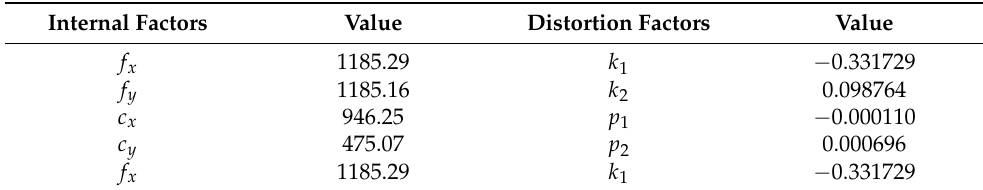
Table 3. SNO-6084R CCTV camera internal factors and distortion coefficients.